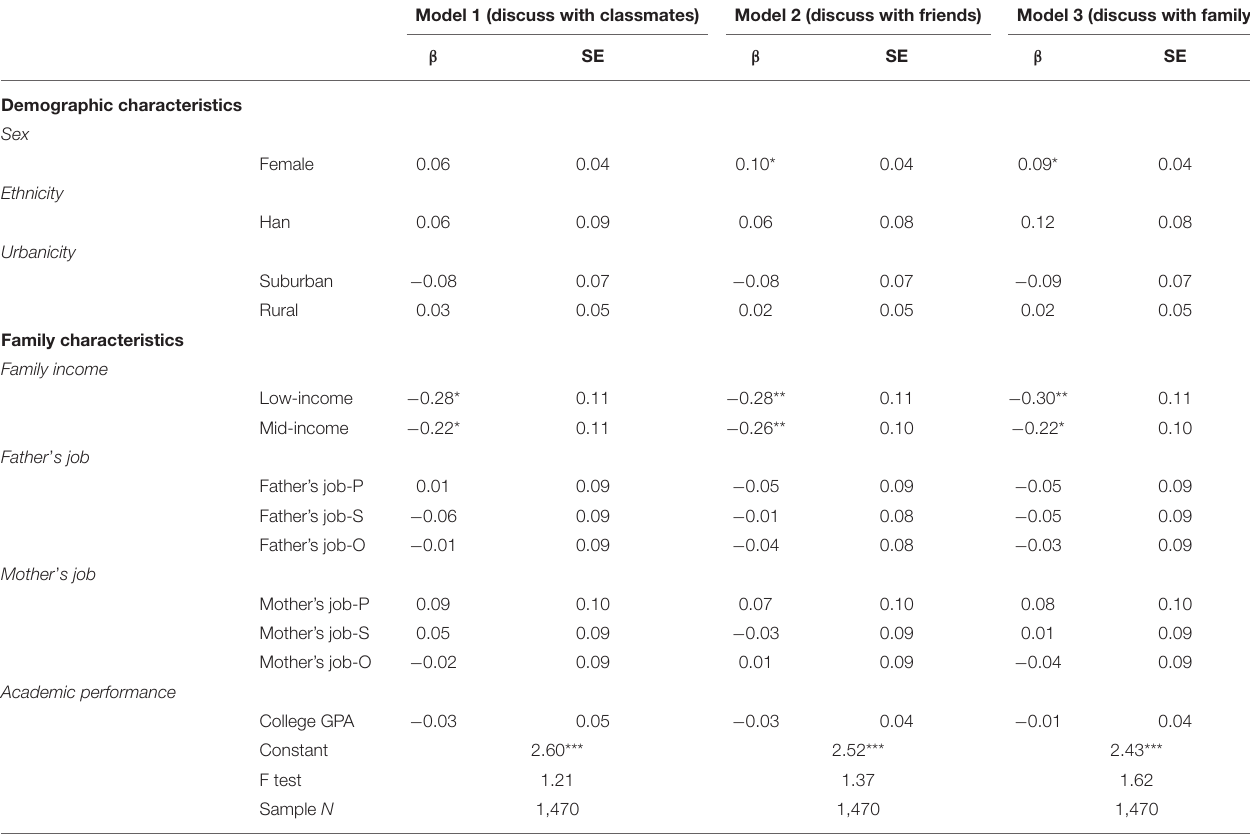
TABLE 3 | The relationships between family characteristics and students’ COVID-19 awareness. Model 1 (discuss with classmates) Model 2 (discuss with friends) Model 3 (discuss with